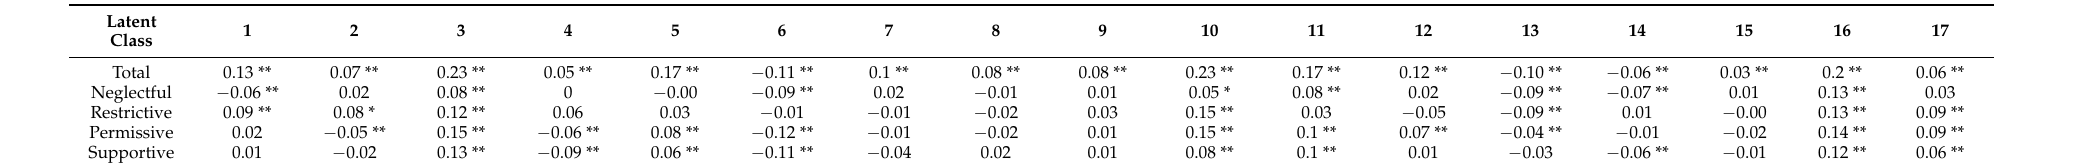
Table A3. Correlations between academic achievement and indicators in each latent